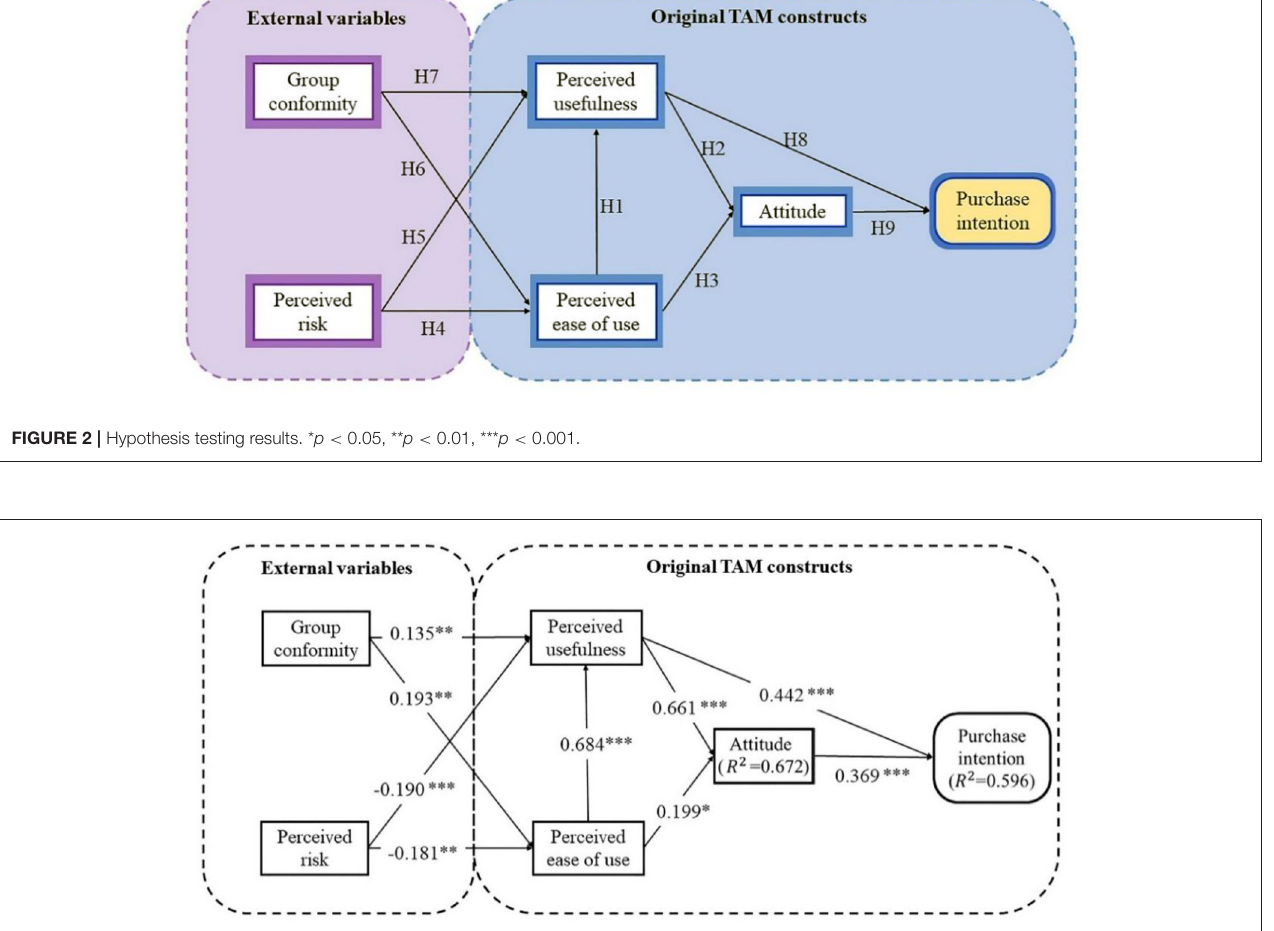
FIGURE 3 | Research